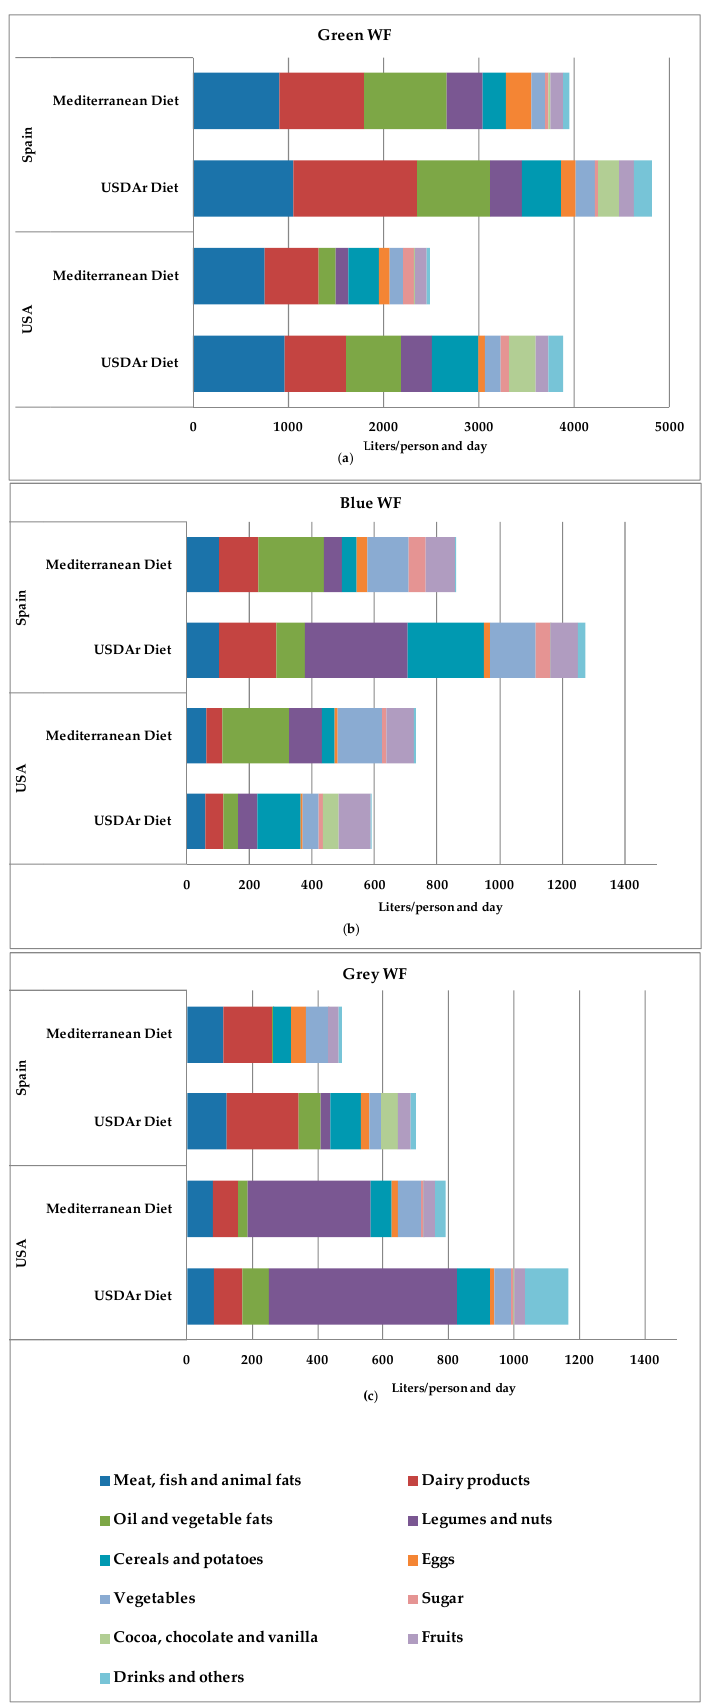
Figure 2. Characterization of the green ( a ), blue ( b ) and grey ( c ) components of the WF diet of the Mediterranean and USDAr diets in Spain and the US for the different product groups.